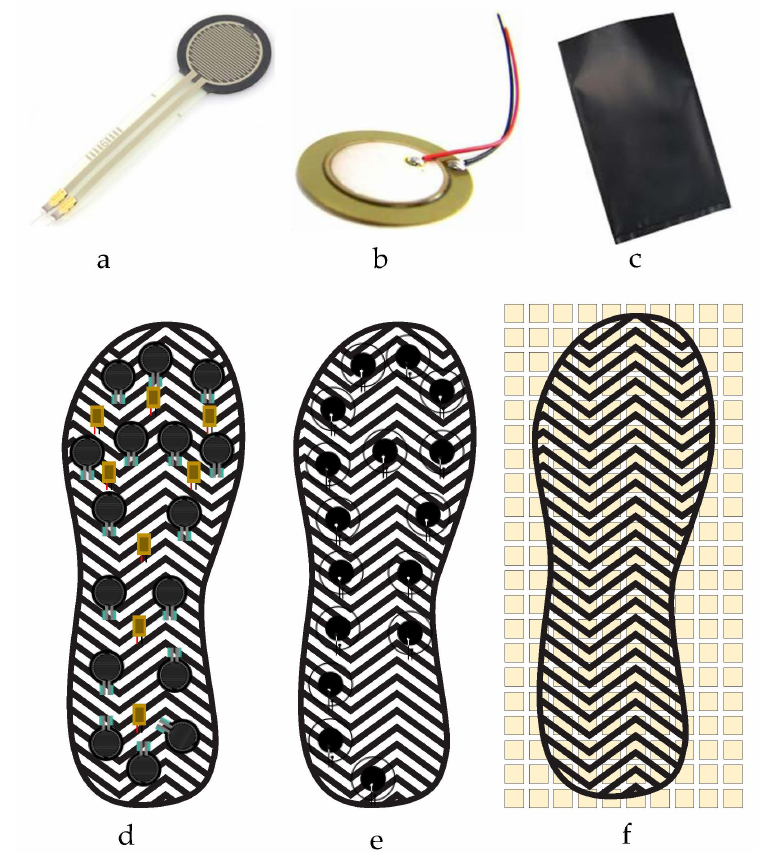
Figure 2. Three different electronic pressure sensors and their placements: ( a ) FSR, ( b ) Piezo-electric, ( c ) Velostat sensors; and ( d ) FSRs, ( e ) Piezoelectric Sensors and ( f ) the Velostat Sheet (with switching matrix) on an Insole.